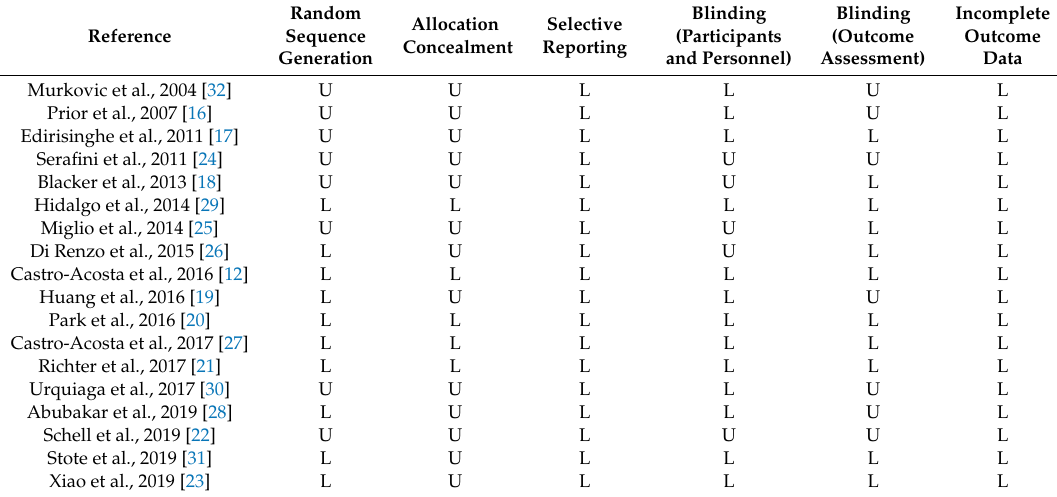
Table 2. Risk of bias assessment for included